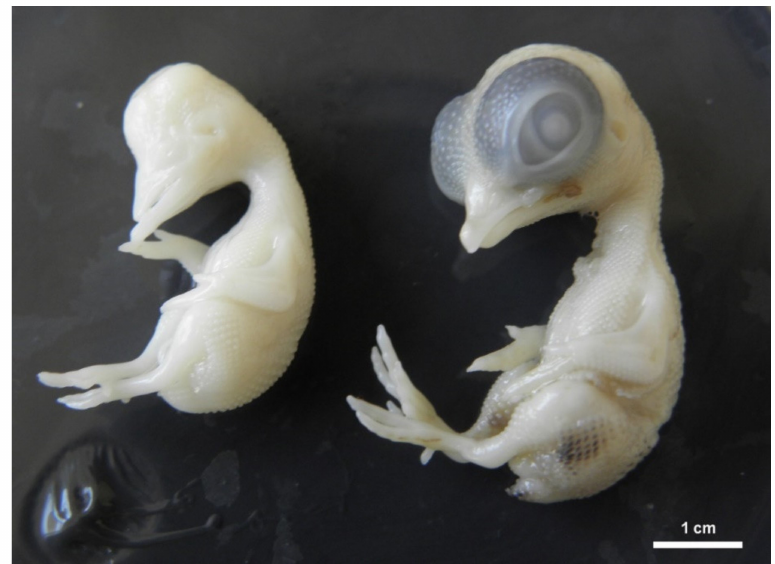
Figure 3. Chicken embryo development on ED 9. Right position: physiological development, left position: general growth retardation with